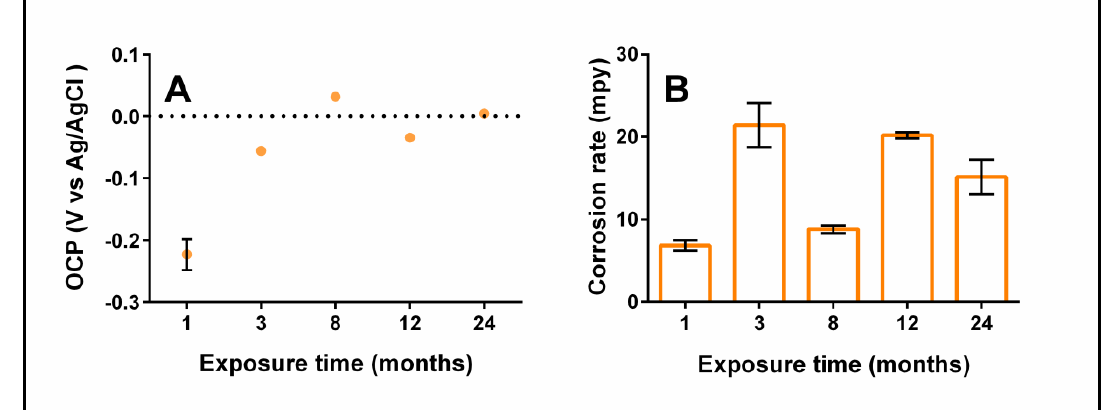
Figure 5. Summary of electrochemical results. OCP evolution ( A ), and variation in the corrosion rate ( B ) over time.